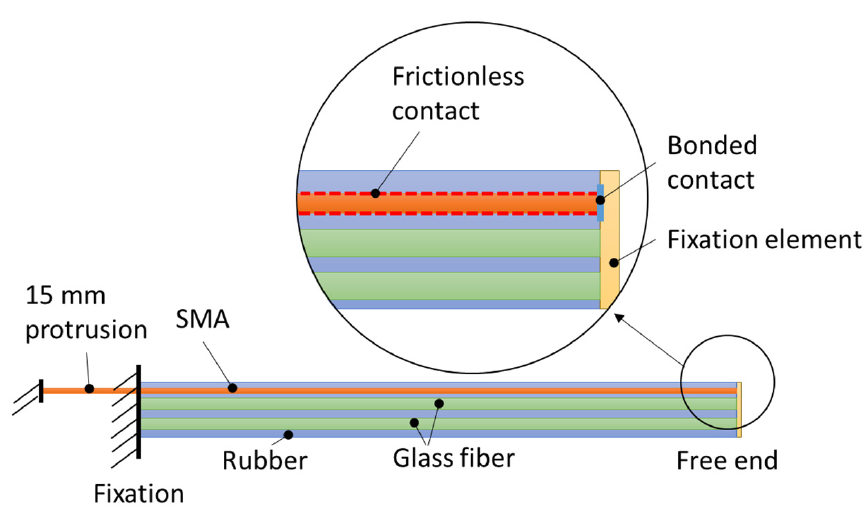
Figure 10. IFRC model boundary condition.